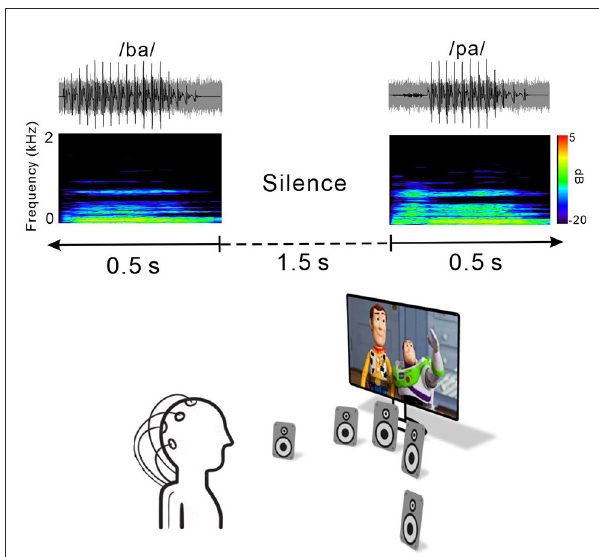
FIGURE1 Speech stimulus and experimental listening conditions. Top, time waveforms of the CV syllable /ba/ and /pa/ with + 5 dB speech-shaped masking noise. Middle, spectrogram of the acoustic stimuli. Each stimulus was embedded in 1.5s of silence.